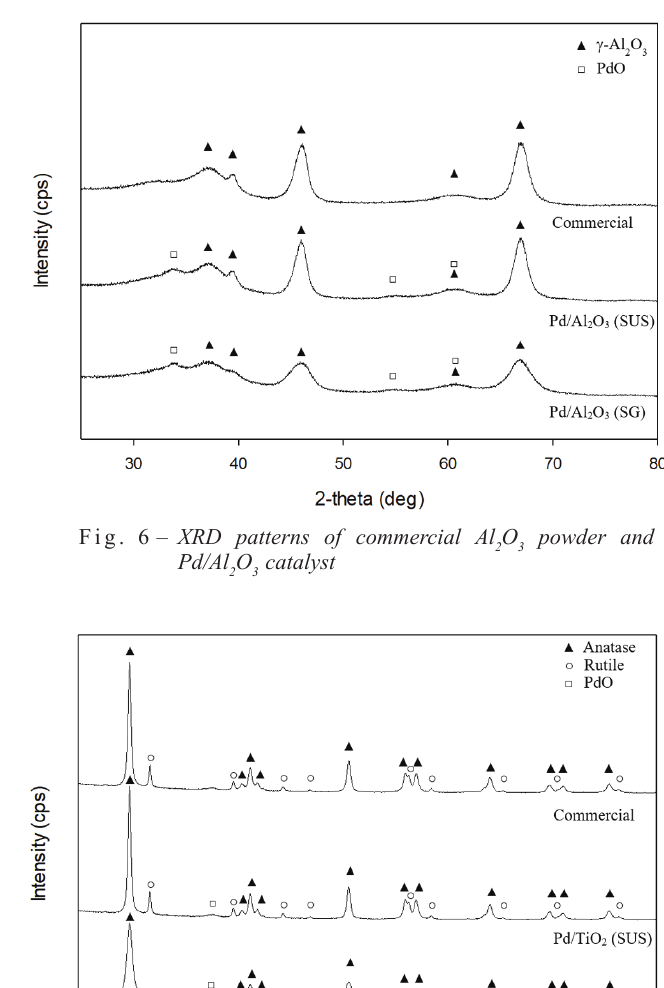
Fig. 7 – XRD patterns of commercial TiO Pd/TiO 2